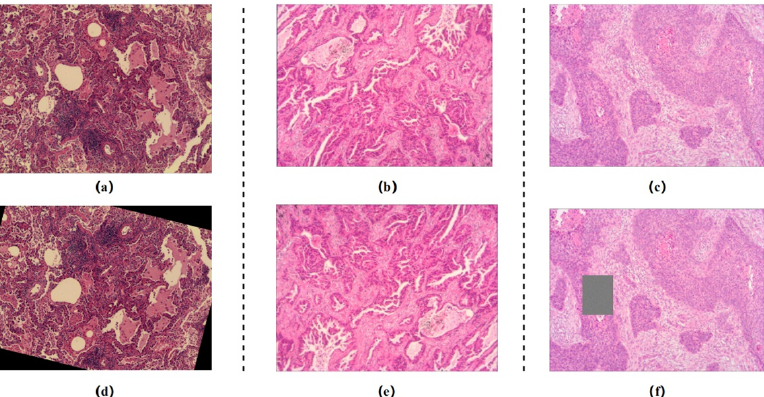
Figure 1. Lung adenocarcinoma data: representative pathological images of ( a ) microinvasive lung adenocarcinoma, ( b ) invasive lung adenocarcinoma, and ( c ) normal lung tissue; data enhancement operations: ( d ) random sample rotation, ( e ) random flip, and ( f ) random region masking. (The initial size of the images are 2048 × 1536 and are resized to 224 × 224).